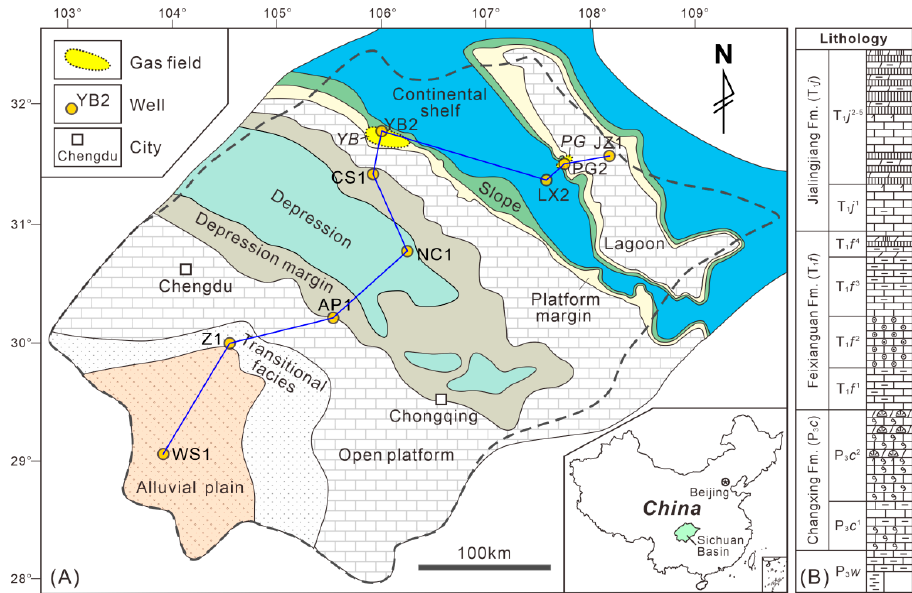
Figure 1. ( A ) Location map showing the Yuanba (YB) gas filed in the Sichuan Basin and sedimentary facies during the deposition of the P 3 c (Modified from Du et al. [32]). PG, Puguang gas field. ( B ) Generalized stratigraphy of the Upper Permian and Lower Triassic in the northeast Sichuan Basin. The lithology legends are shown in Figure 2. Fm., Formation.